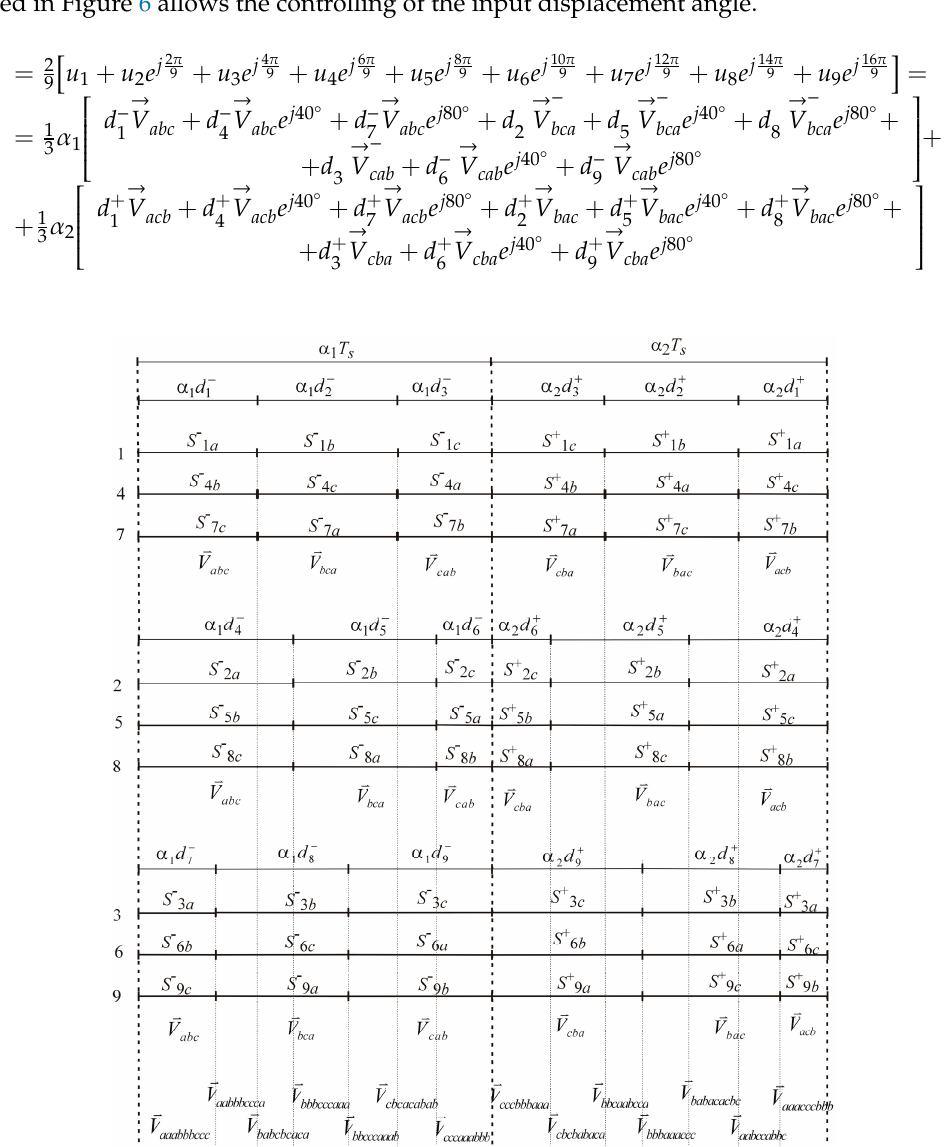
Figure 6. Switch duty cycles during T s switching period in three-to-nine-phase MC for output phase numbers 1, 4 and 7; numbers 2, 5, and 8; numbers 3, 6, and 9. Table 3. Rotating voltage space vectors leading to elimination the CMV in three-to-nine-phase MC. V The output voltage space vector (27), averaged in T s period, depends on input voltage o CCW Rotating Vectors CW Rotating rotating space vectors (Table 1), resulting in zero value of CMV. The